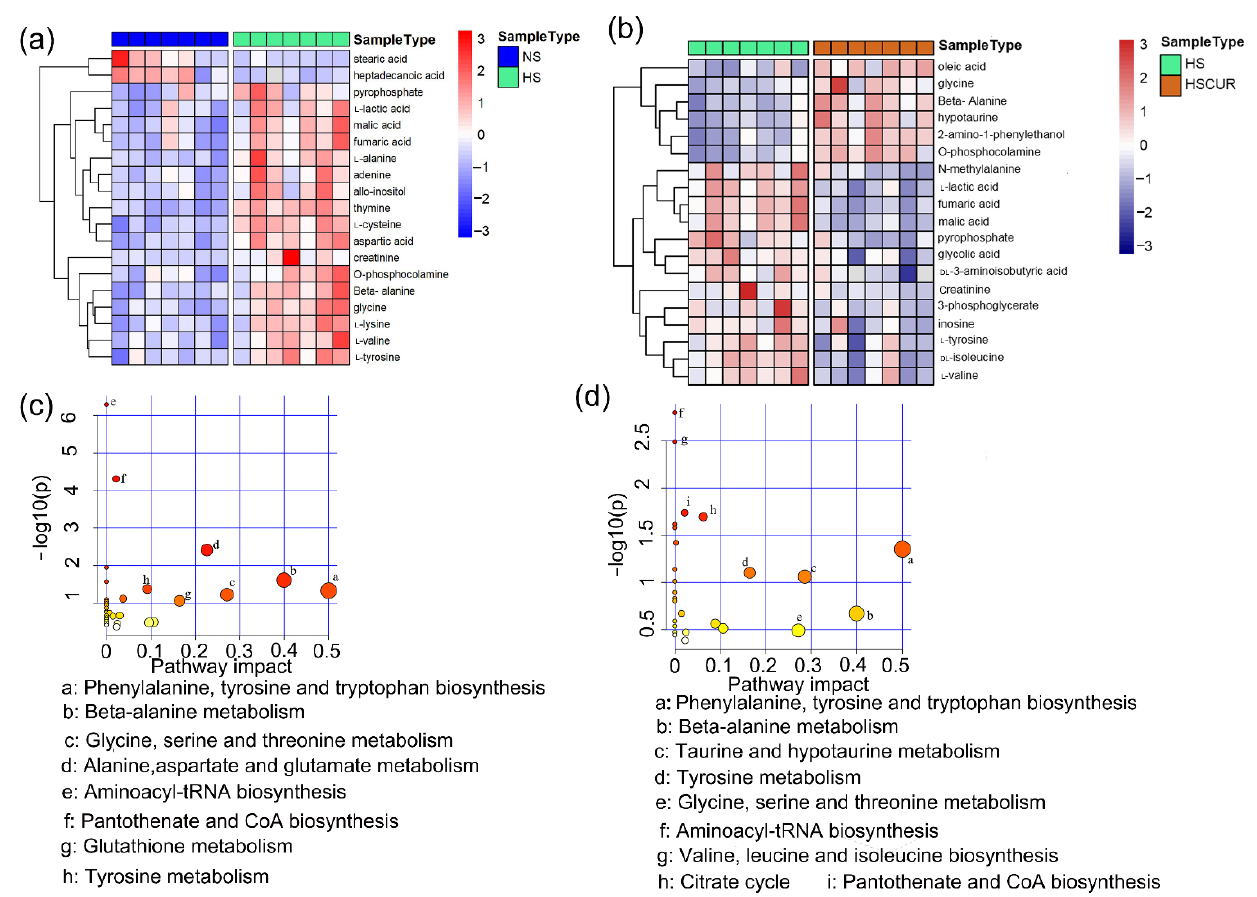
Figure 3. Hepatic metabolomics analysis. Differential metabolites in liver tissues between the HS and NS groups ( a ), or the HS and HSCUR groups ( b ); metabolic pathway enrichment analysis based on differential metabolites between the NS and HS groups ( c ), or the HS and HSCUR groups ( d ). The difference in the Mann–Whitney–Wilcoxon test with the false discovery rate (FDR) using Benjamini–Hochberg (BH) method adjusted p -value less than 0.05 was considered significant. Colors in sub-figures ( c , d ) were determined by –log10 ( p ) values, pathways with higher –log10 ( p ) were shown in red, and vice were shown in yellow.